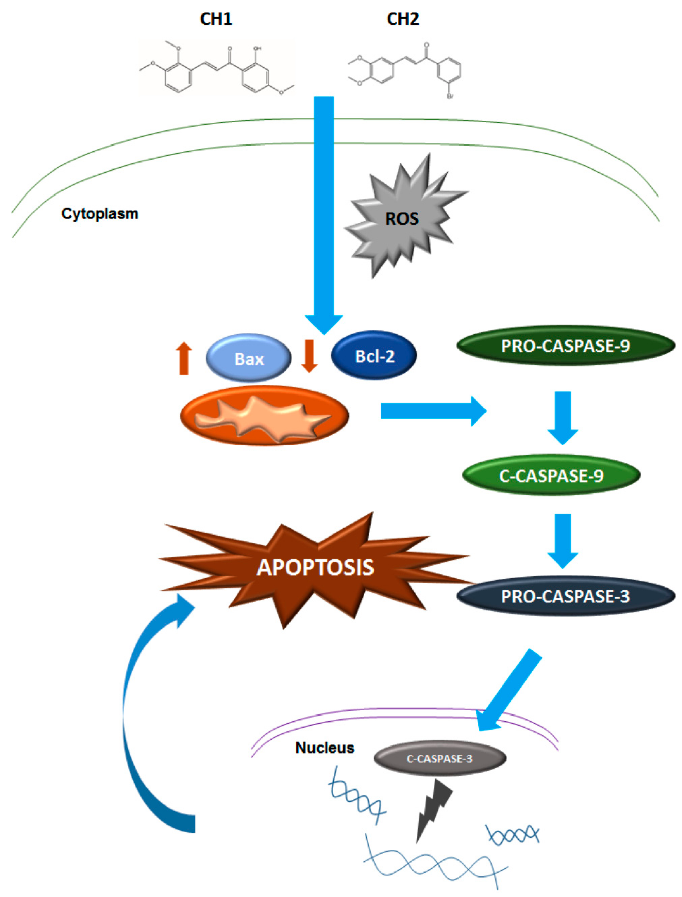
Figure 12. Proposed model for Chalcone-mediated apoptosis in human hepatoma cells. Solid arrow represent activation.